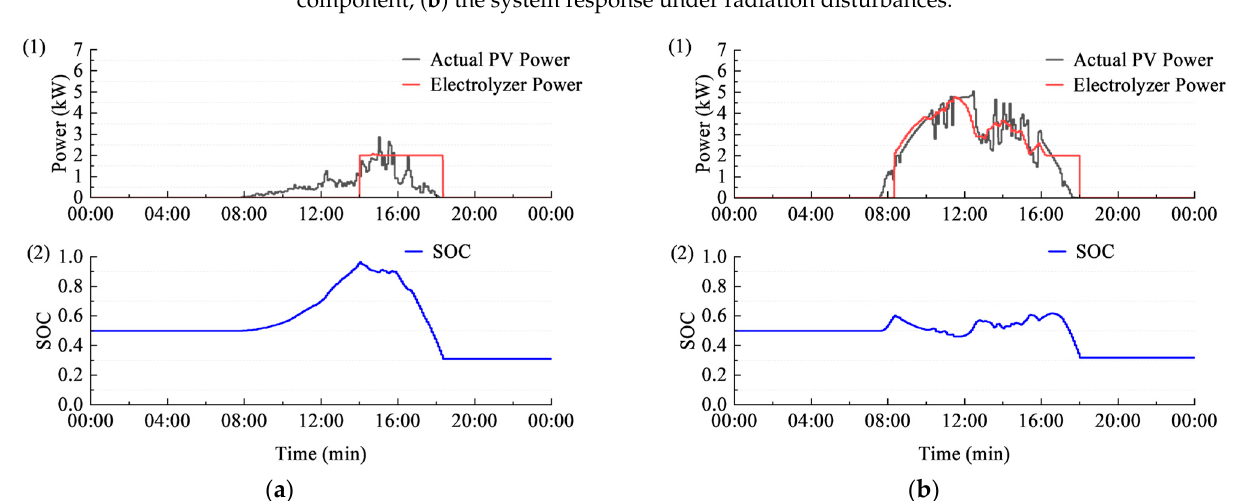
Figure 8. System operation status including actual PV power, electrolyzer power in ( 1 ), and SOC of the day using proposed energy management strategy in ( 2 ). ( a ) Operation status on day 1 with insufficient PV power; ( b ) operation status on day 2 with sufficient PV power.